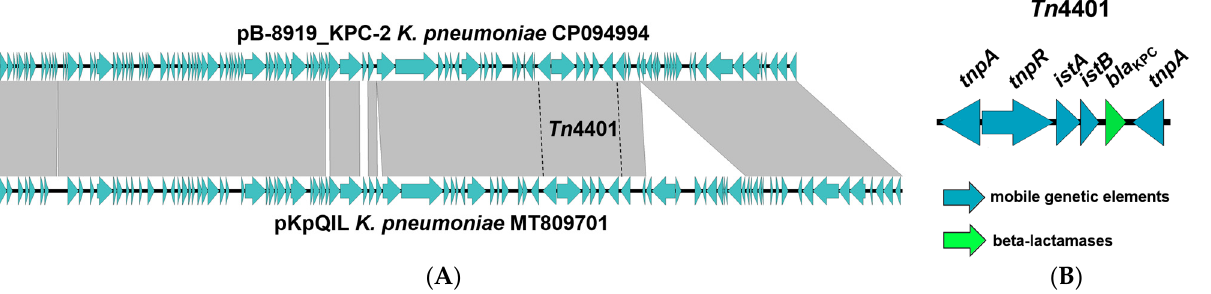
Figure 4. Easyfig comparison of IncFIB(pQil) plasmids ( K. pneumoniae strain SCPM-O-B-8919 and K. pneumoniae strain 02288527-42B) ( A ). structure of transposon (Tn4401) with location of carbapenemase gene bla KPC-2 ( B ). The arrows show the orfs , their length, and their orientation.